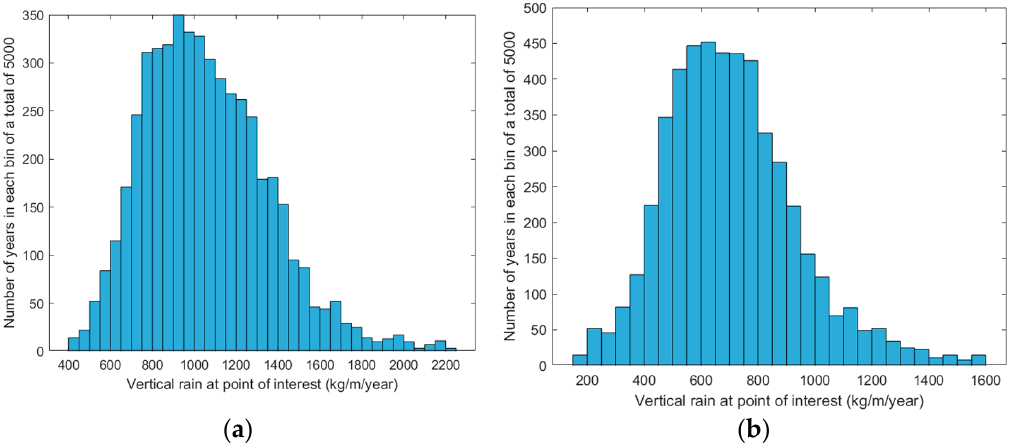
Figure 10. Rain load at the catch area of the joint in the studied facade (kg/year); ( a ) driving rain at all pressure differences; ( b ) driving rain when the pulsating pressure over the building envelope was estimated to exceed 60 Pa.